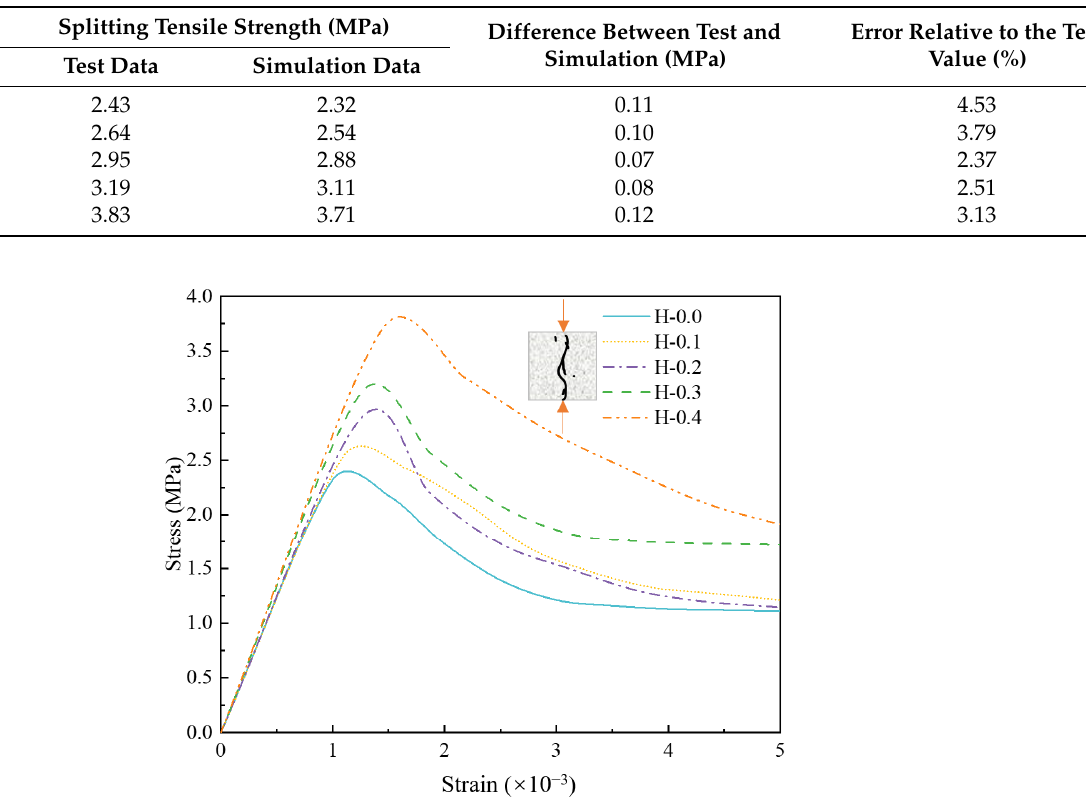
Table 14. Comparison of test and simulated splitting tensile strength values of hybrid BF ‐ PVAF ‐ reinforced LHPCC.